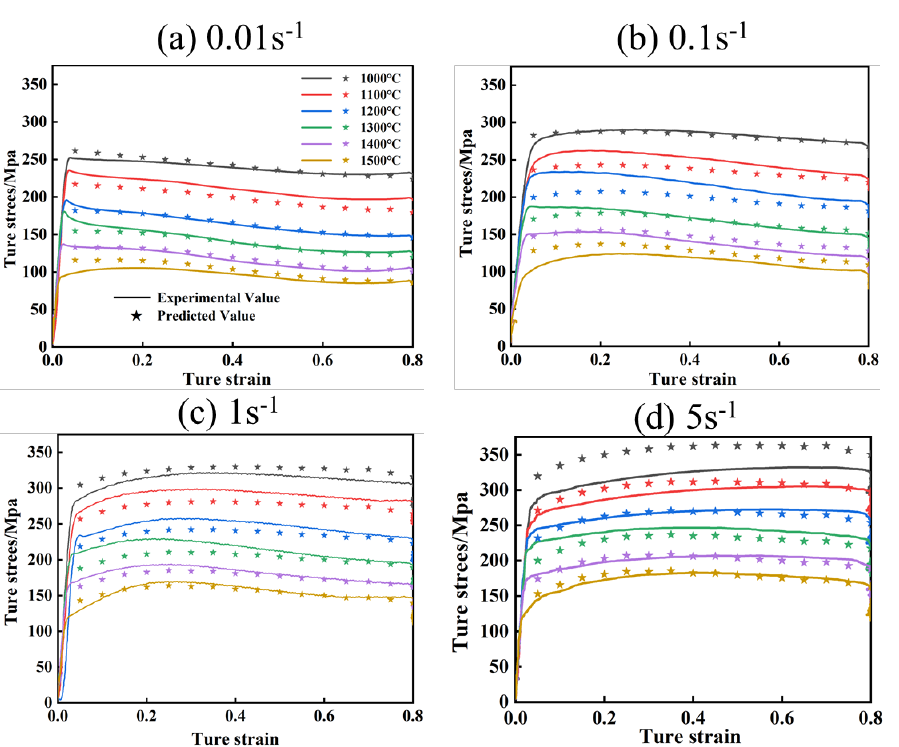
Figure 11. Comparison of experimental and calculated values of flow stress of Mo − 1.5wt% Al 2 O 3 :